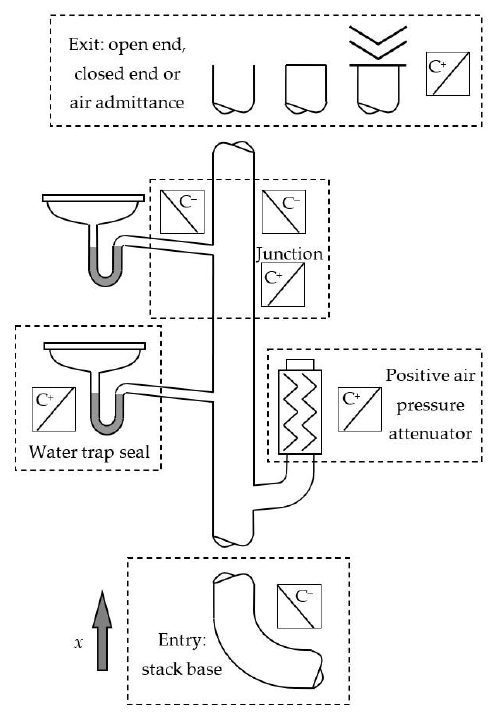
Figure 3. Boundary conditions and available characteristics for a typical building drainage